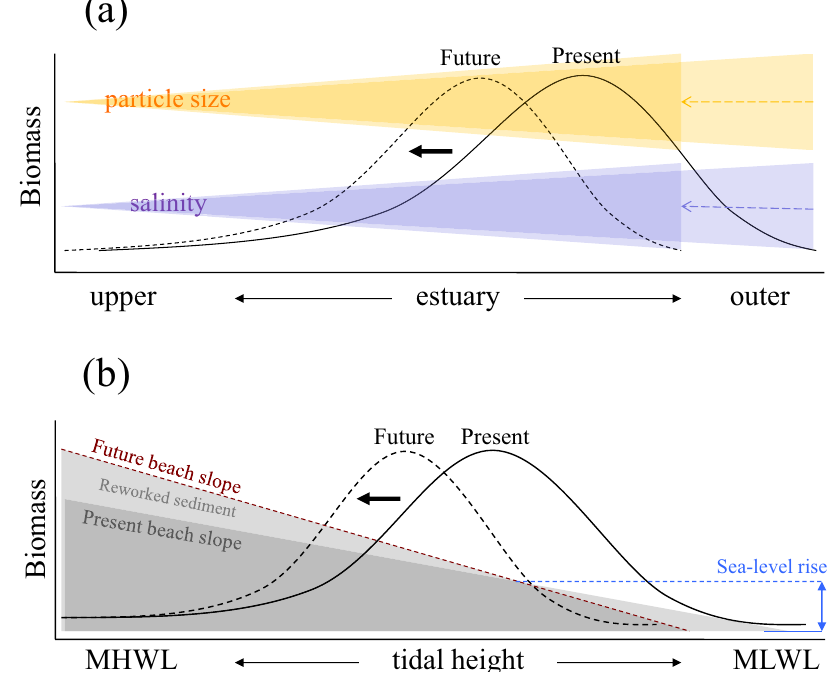
Figure 2. Schematic representation of relations between estuarine intertidal macrobenthic biomass and key environmental factors with conceptual models illustrating possible shifts in the biomass distributions in response to sea-level rise: ( a ) along estuarine longitudinal gradient with biomass shift due to salinity intrusion upstream and change in particle size distributions resulting from sea-level rise; ( b ) along estuarine vertical gradient over intertidal flat with biomass shift due to change in intertidal beach profile. The black solid and dotted lines represent present and future distributions of macrobenthic biomass, respectively. In diagram ( b ), the blue dashed line indicates increased sea level and the brown dashed line represents newly established intertidal profile in response to sea-level rise. MHWL and MLWL represent mean high water level and mean low water level,